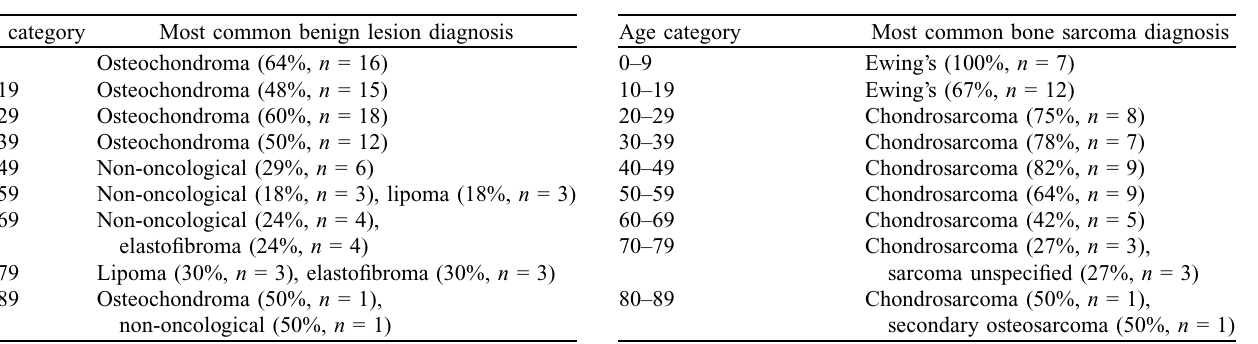
Table 2. Most common benign lesions according to age. Table 5. Most common bone sarcomas according to age.